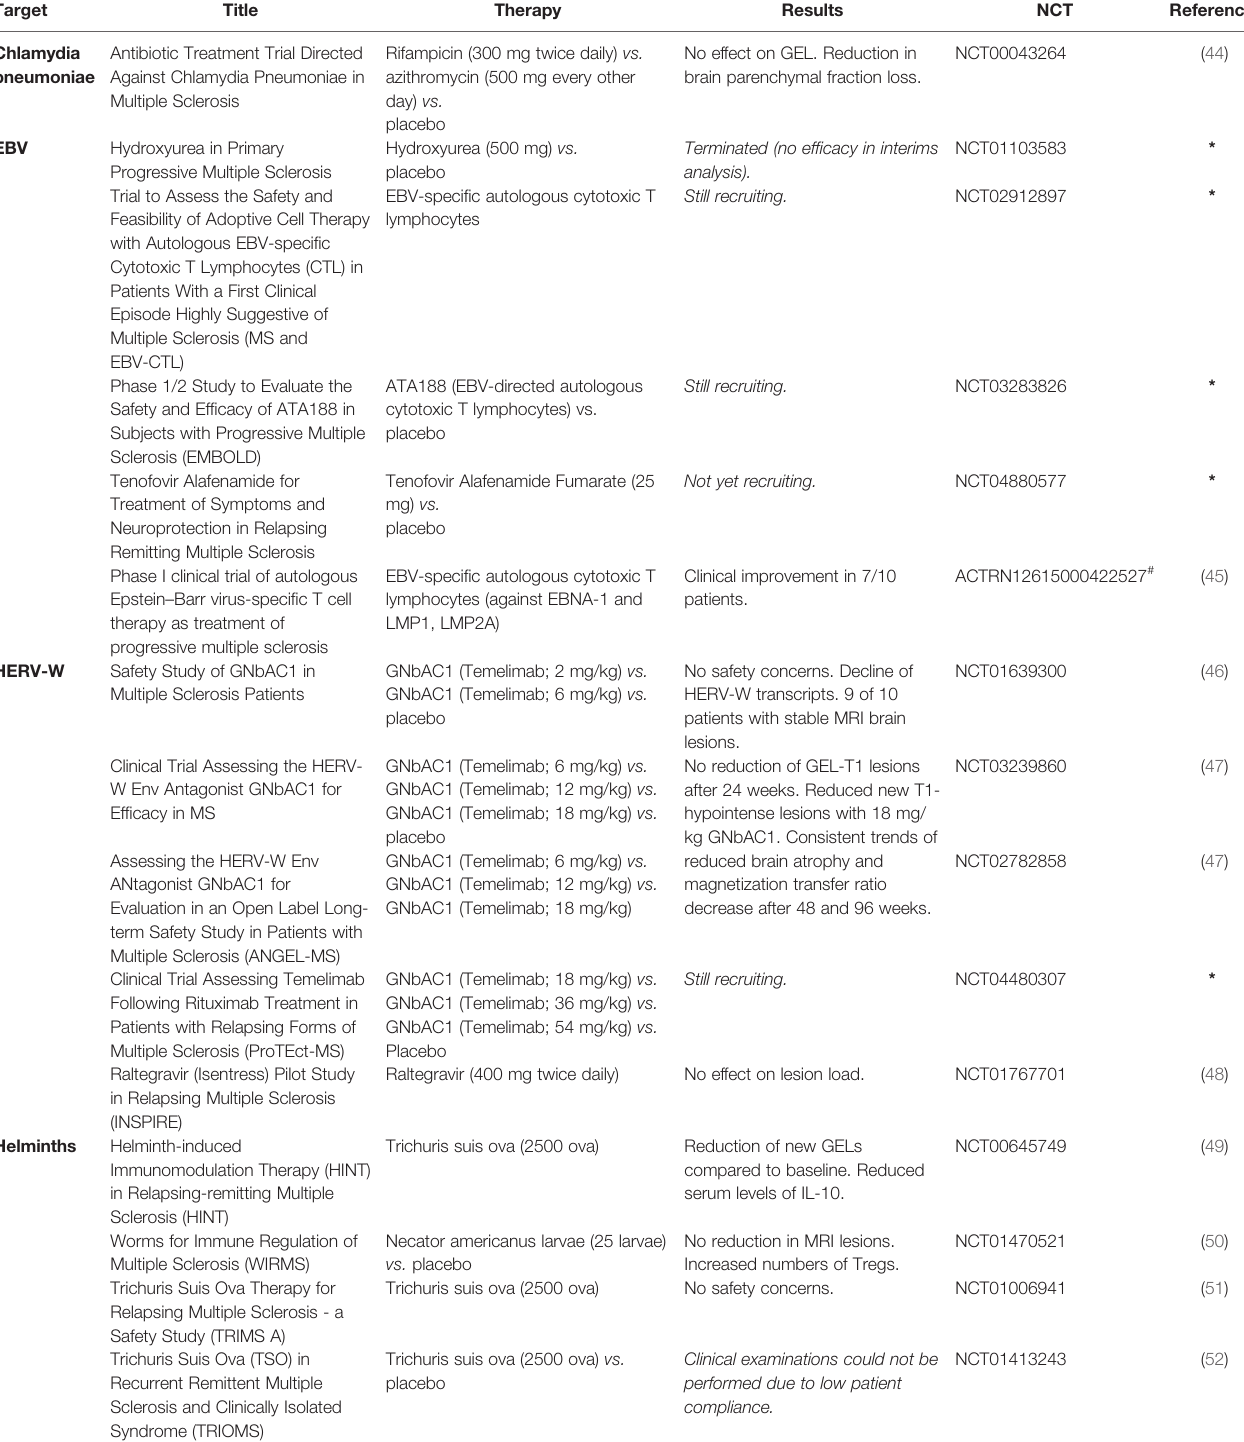
TABLE 2 | Clinical studies on pathogen-derived targets in multiple sclerosis.